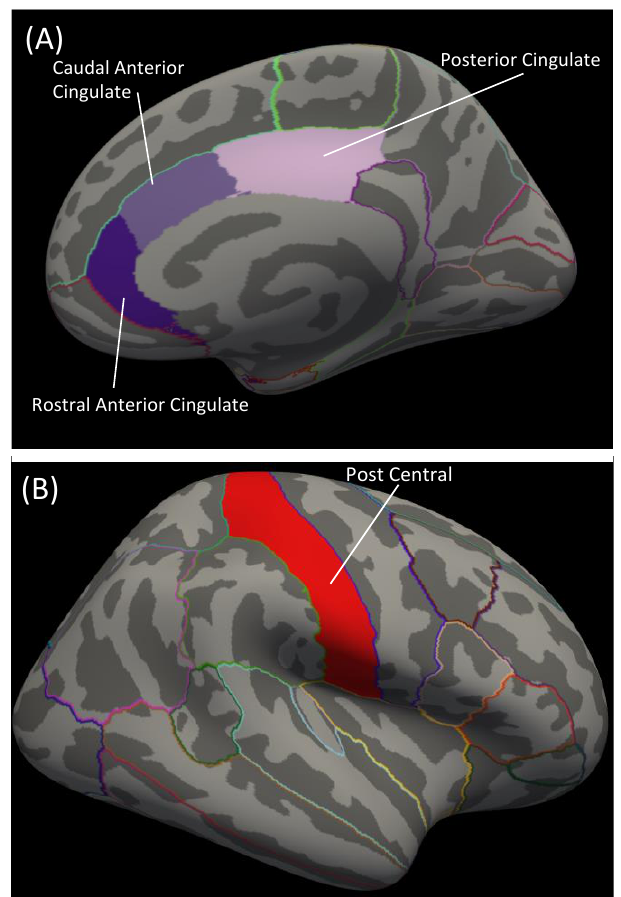
Figure 1. Schematic of FreeSurfer brain regions used in analyses. ( A ) Right hemisphere cingulate cortex parcellations used in primary analyses. Dark purple = rostral anterior cingulate; medium purple = caudal anterior cingulate; light purple = posterior cingulate. ( B ) Red = right hemisphere post central parcellation used as the control region analysis.